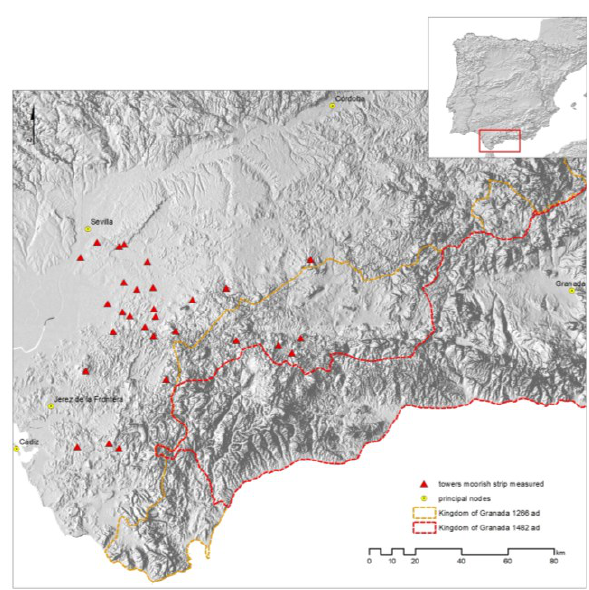
Figure 1: Location of the towers of the Moorish Strip.